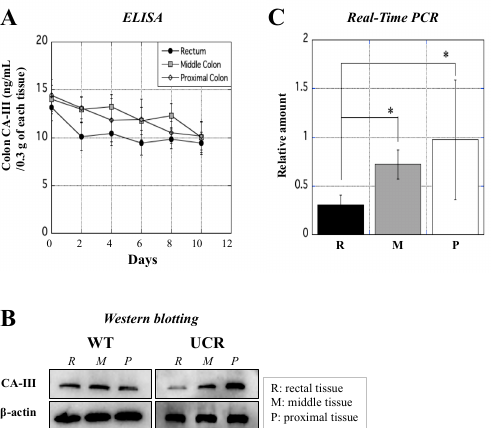
Figure 6. Measurement of CA-III concentrations in the colon of WT and UCR by ELISA, western blotting, and real-time PCR. ( A ) Concentration of CA-III (ng/mL/0.3 g of each tissue) in the large colon (rectum, middle colon, and proximal colon) of WT (Day 0) and UCR (Days 2–10) was measured by ELISA. X-axis indicates days after the start of the experiment, while Y-axis indicates the concentration of CA-III (ng/mL/0.3 g of each tissue) in each region. Data are the mean ± SD. ( B ) Western blotting was performed to detect CA-III in each colonic region (Figure S3). The upper and lower panels show the expression of CA-III and β -actin (internal control) protein, respectively, in the rectum (R), middle colon (M), and proximal colon (P) in WT (left panel) and UCR (right panel). ( C ) Real-time PCR shows the relative amount of CA-III mRNA in each colonic region of UCR against that of WT. X-axis indicates each region, while Y-axis indicates the relative amount of CA-III mRNA in each segment of UCR against that of WT. Data are the mean ± SD. * p < 0.05. WT: Wild type Slc:Wistar rats; UCR: Slc:Wistar rats treated with 5% dextran sulfate sodium; CA-III: carbonic anhydrase